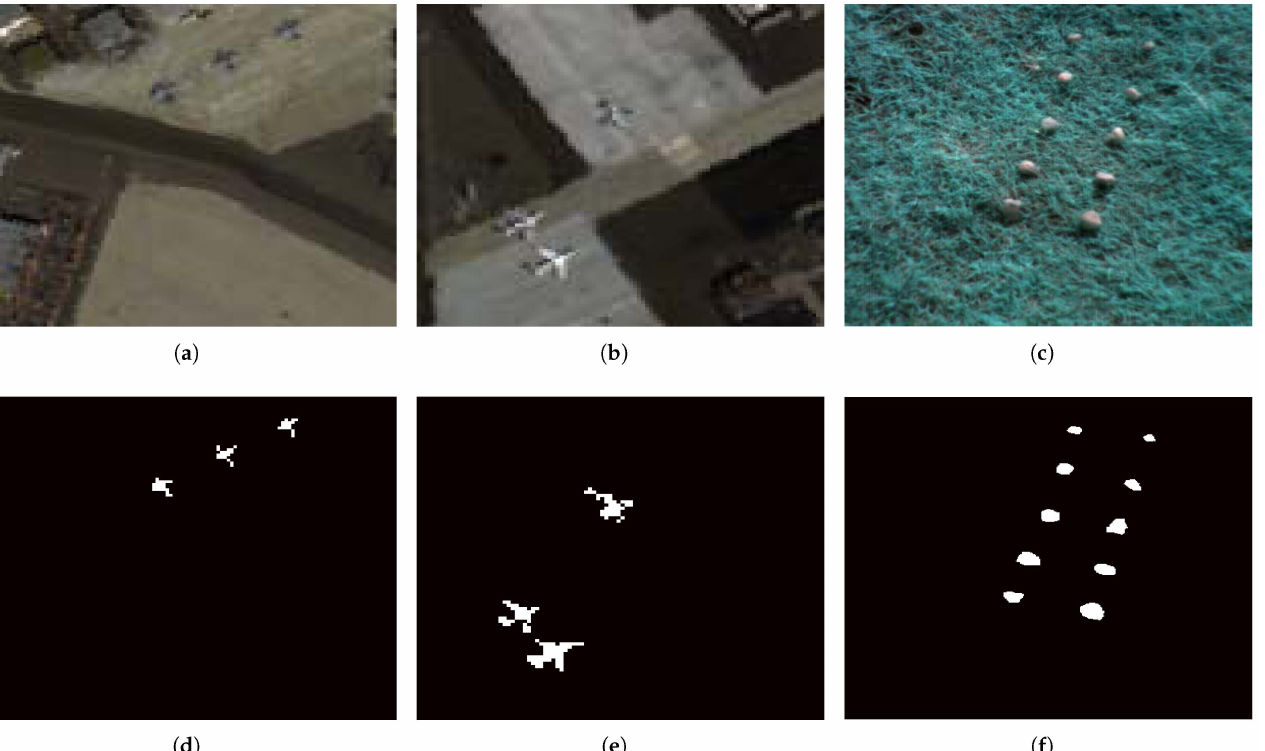
Figure 3. Image scene descriptions. ( a ) False color image of the AVIRIS-I dataset. ( b ) False color image of the AVIRIS-II dataset. ( c ) False color image of the Cri dataset. ( d ) The ground truth map of the AVIRIS-I dataset. ( e ) The ground truth map of the AVIRIS-II dataset. ( f ) The ground truth map of the Cri